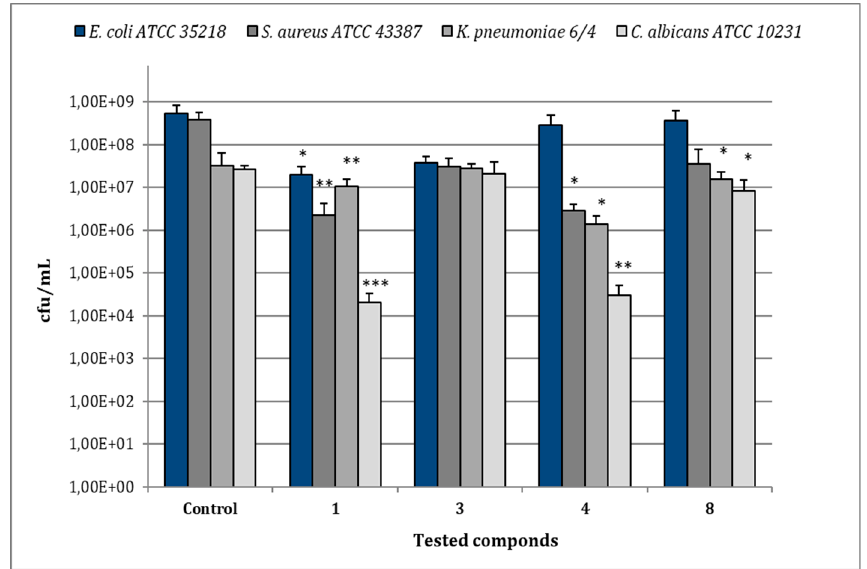
Figure 6. Assessment of viable cells harvested from biofilms of E. coli ATCC 35218, S. aureus ATCC 43387, K. pneumoniae 6/4 and C. albicans ATCC 10231 after 30 min of treatment with compounds 1 , 3 , 4 , and 8 at their relative MIC values. Data represent the mean ± SD of cfu/mL values obtained in three independent experiments performed in duplicate. Asterisks represent values statistically significant (* p < 0.05; ** p < 0.01; *** p < 0.001) as compared to the related controls.